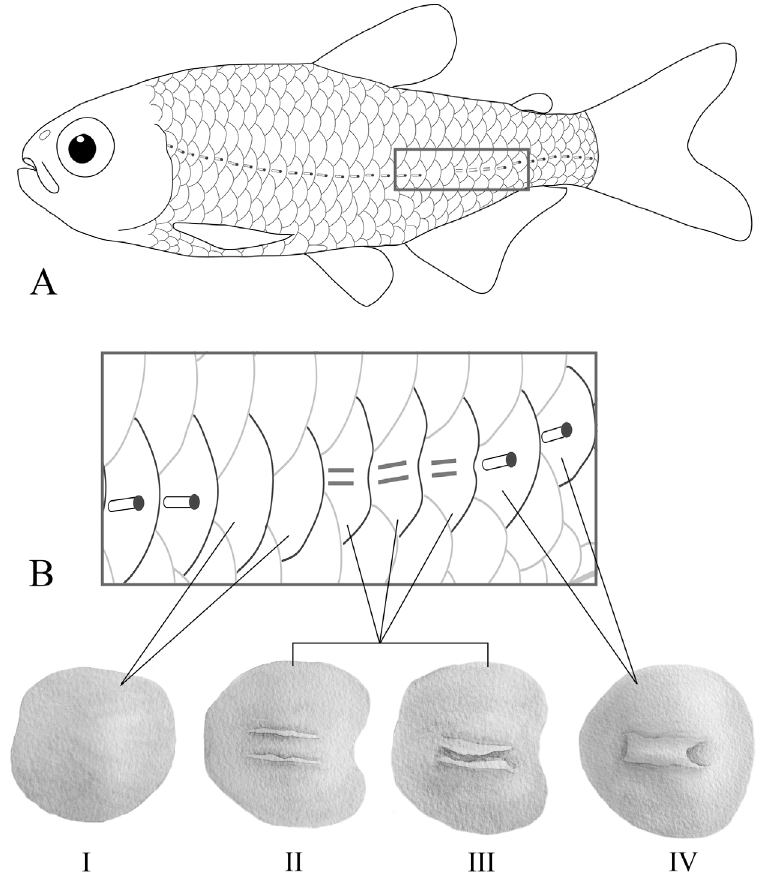
FIGURE 3 | Schematic drawing of Moenkhausia cambacica showing A . lateral-line perforation pattern observed in most specimens. B . Morphology of the lateral-line scales above anal fin: I – scale lacking tube and pore; II – scale with poorly developed tube, with small tube walls; III – scale with poorly developed tube, walls larger but not enclosed; IV– scale with fully developed bony tube, tube walls enclosed, with a posterior